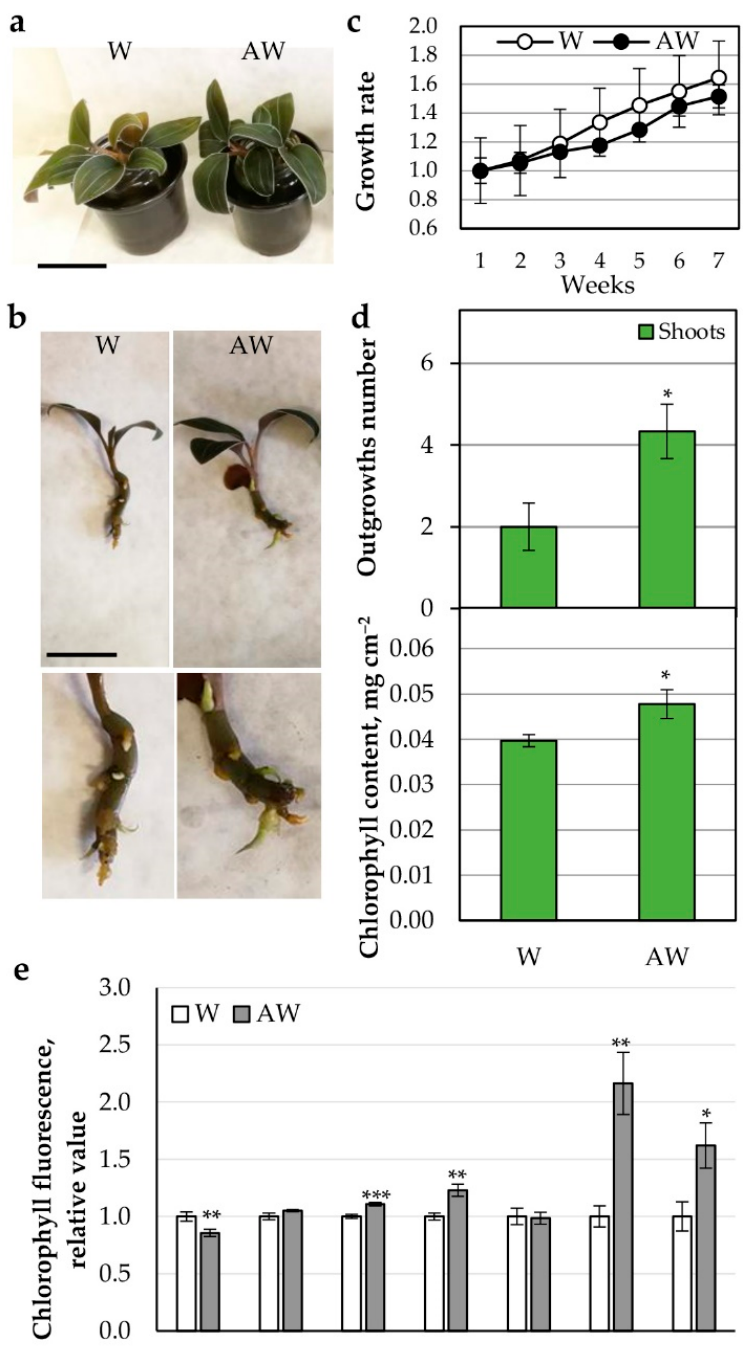
Figure 2. Growth of L. discolor hydroponic culture under treatments with AW. The plants were cultivated as hydroponic cultures for 7 weeks. ( a,b ) Photo of the variants: W, water; AW, aquaponic water; Scale bar: 5 cm. ( c ) Growth rate of L. discolor fresh biomass for 7 weeks relative to the fresh biomass at Week 1. ( d ) Growth parameters at Week 7: number of outgrowths, chlorophyll content. ( e ) Chlorophyll fluorescence parameters. Statistically significant differences compared with the control W are shown with asterisks after application of Student’s t -test (* p ≤ 0.05; ** p ≤ 0.001; *** p ≤ 0.0001).